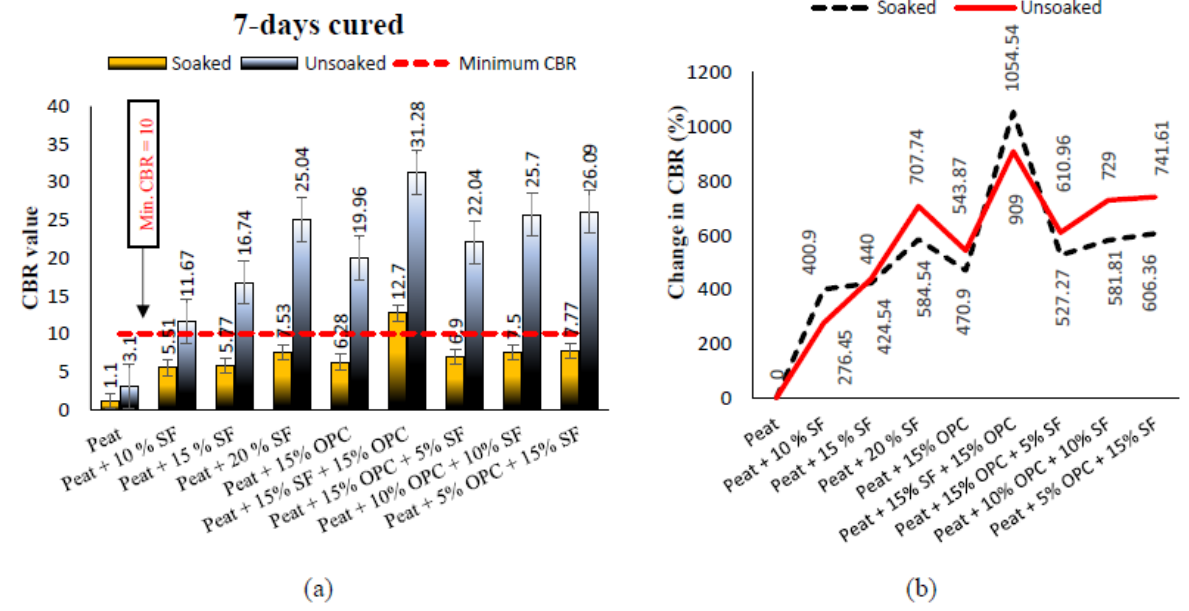
Figure 9. ( a ) The 7 days cured soaked and unsoaked CBR values of treated and untreated Teluk Intan peat; ( b ) changes in soaked and unsoaked CBR values after treatment.